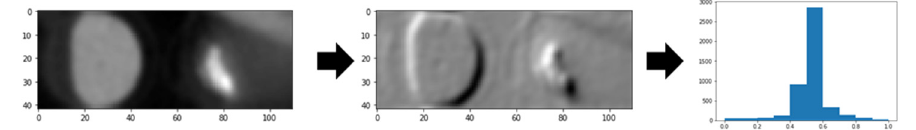
Figure 9. Sobel operator.